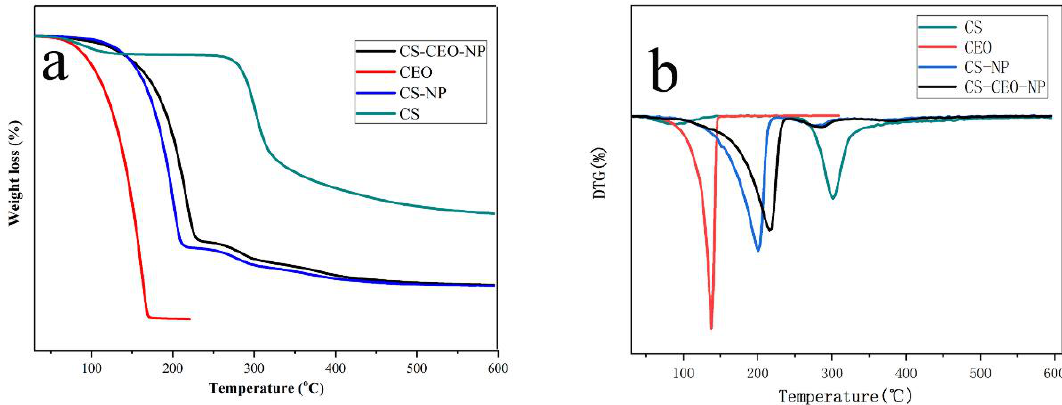
Figure 5. ( a ) TGA and ( b ) DTG thermograms of the CS powder, CEO, CS-NPs, and CS-CEO loaded at Figure 5. (a) TGA and ( b )DTG thermograms of the CS powder, CEO, CS-NPs, and CS-CEO loaded at an initial CEO to CS weight ratio of an initial CEO to CS weight ratio of 0.39:1.